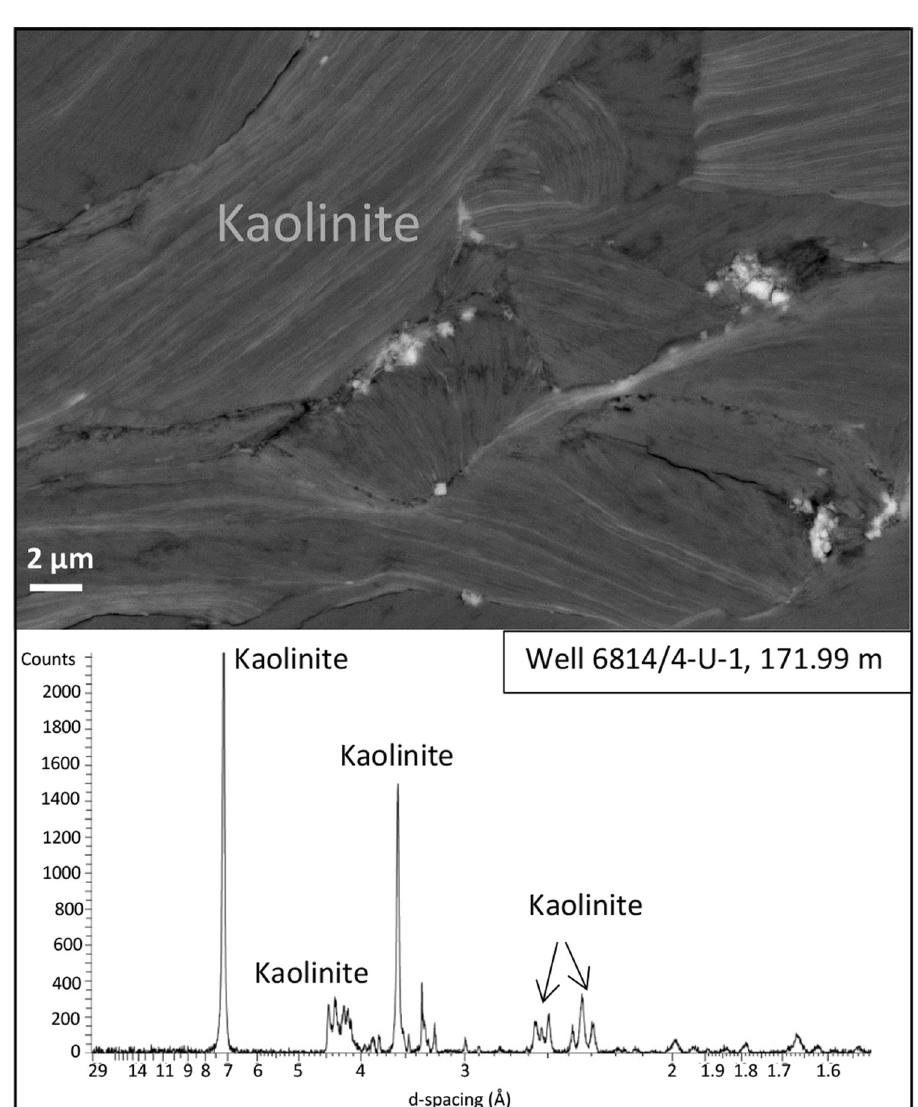
Fig. 3 SEM image and XRD characterization of weathered basement. SEM image and bulk XRD diffractogram of rock sample (171.99 m) in highly weathered basement from well